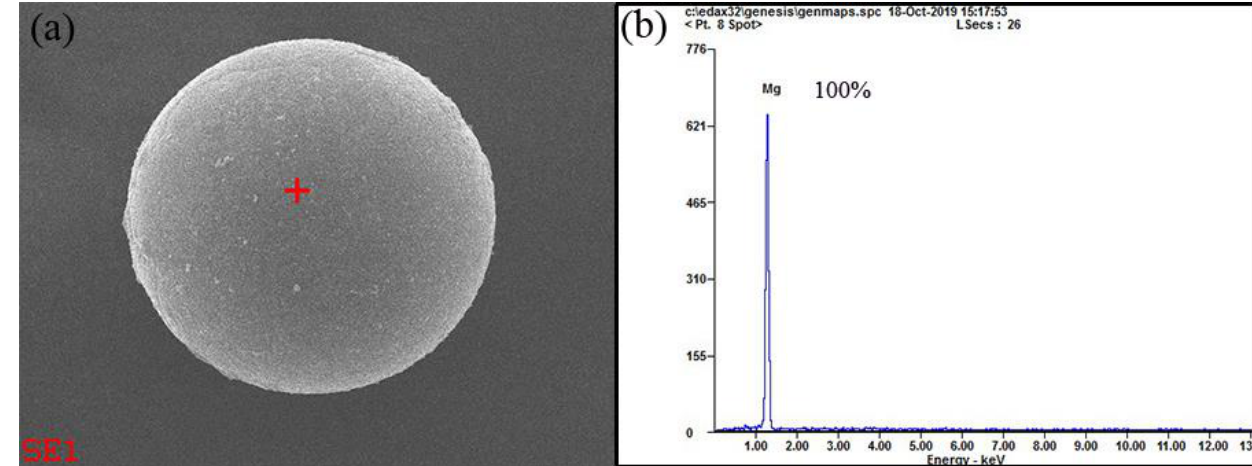
Figure 4. EDS spectrum of Mg microparticles, ( a ) probing position marked as “+“, ( b ) EDS spectrum.